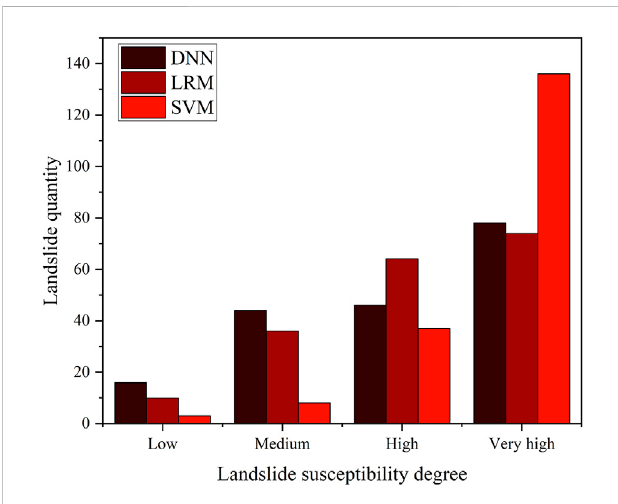
FIGURE 8 Comparison of the number of landslides in each sensitivity area generated using the three